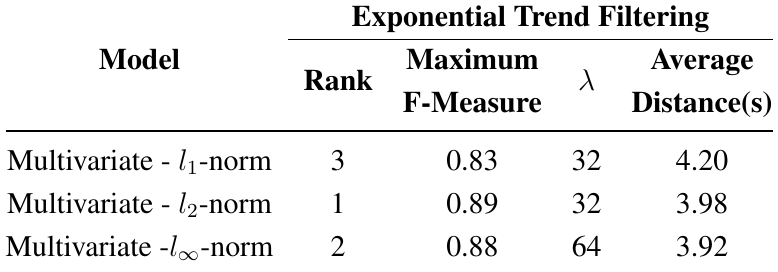
Table 4. Comparison of different norms used to combine the answers of the sensor array.